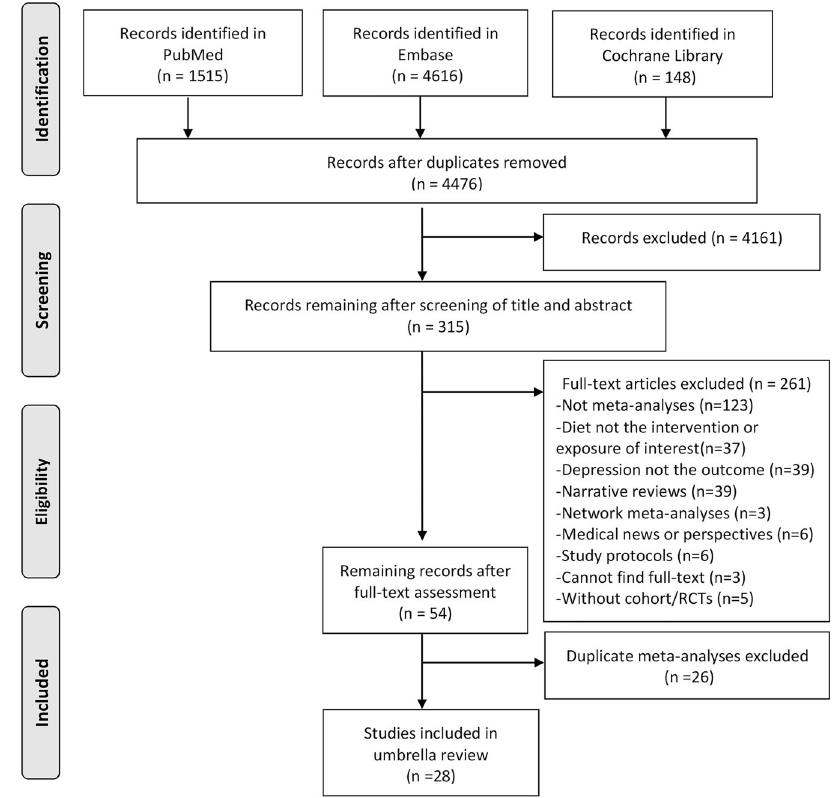
Fig. 1 Flow chart illustrating the literature search process in the umbrella